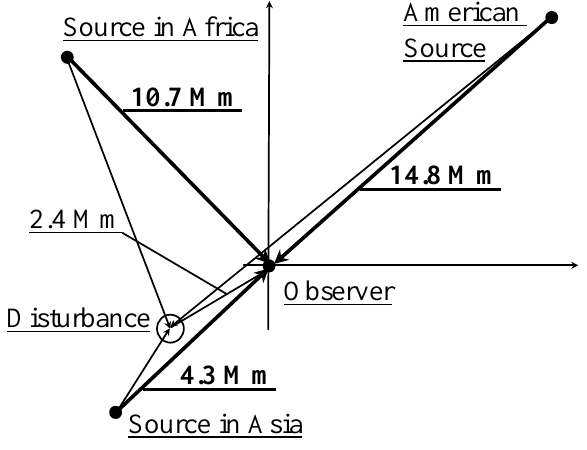
Fig. 4. Scheme of ELF radio propagation in the Earth-ionosphere cavity with a localized disturbance placed over the earthquake epi- center.